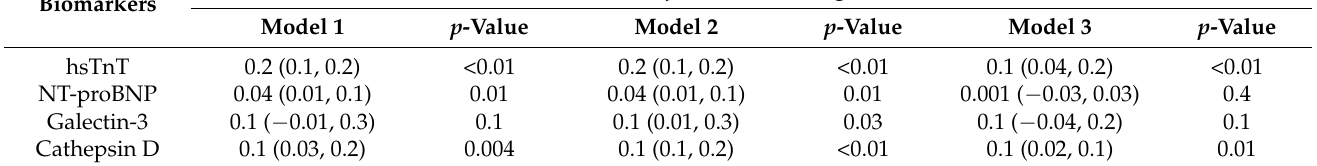
Table 3. Association between circulating CV biomarker levels (log-transformed) and brachial–ankle pulse wave velocity (log-transformed) in hemodialysis participants using the multivariable-adjusted linear regression